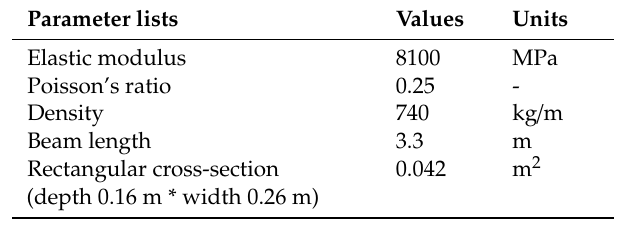
Table 1. Engineering properties employed in the simulation model.